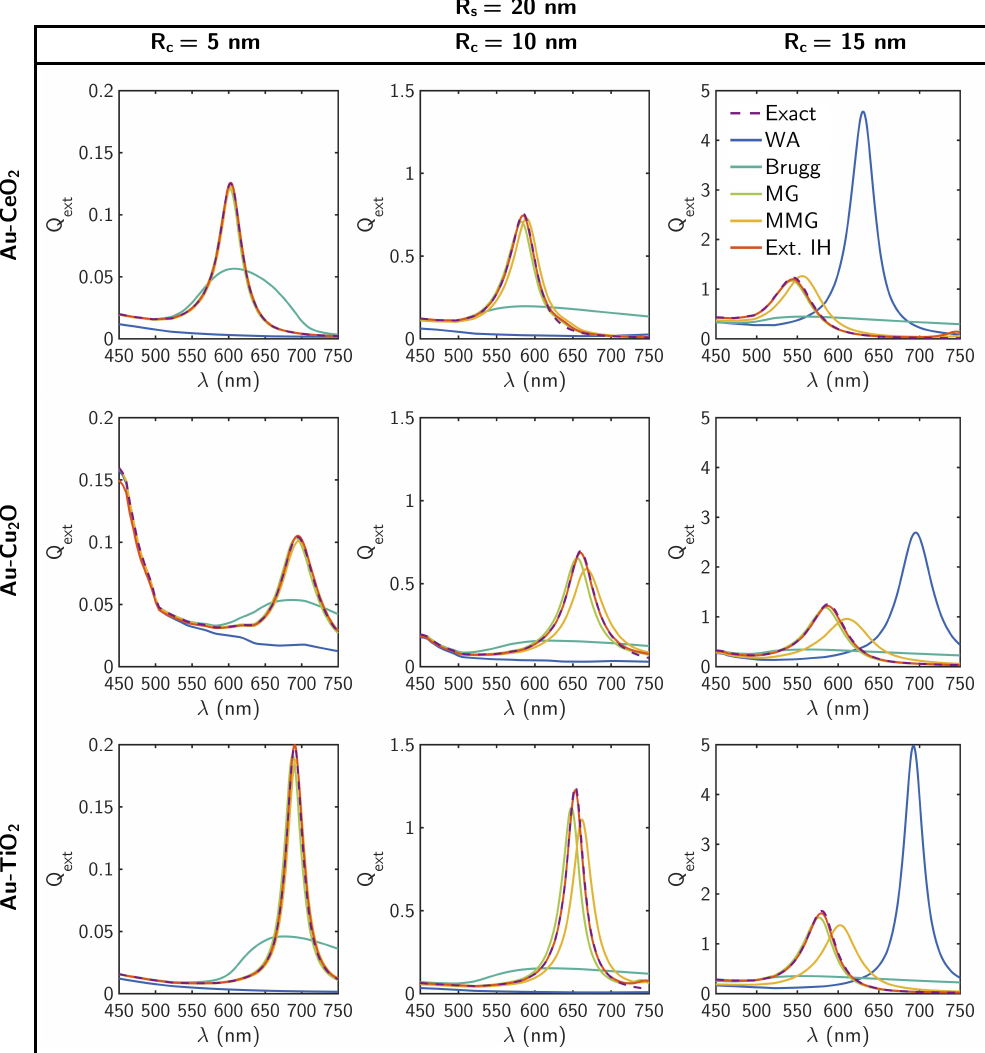
Figure 5. Extinction efficiency ( Q ext ) of Au-CeO 2 (top row), Au-Cu 2 O (middle row) and Au-TiO 2 (bottom row) core-shells of total radius R s = 20 nm and different core sizes: R c = 5 nm (first column), R c = 10 nm (middle column) and R c = 15 nm (right column). The exact solution is compared with different effective medium theories: weighted average (WA), Bruggeman (Brugg), Maxwell Garnett (MG), Mie theory based Maxwell Garnett (MMG) and the proposed approach (Ext.